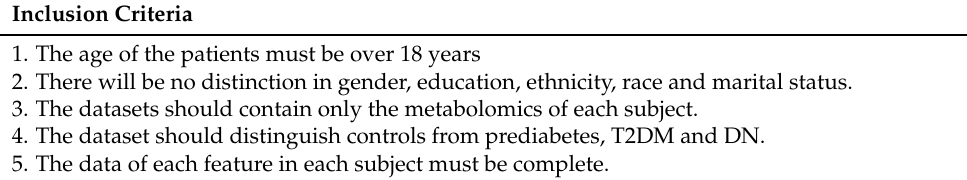
Figure 1. Flowchart of the proposed methodology. The blue squares refer to the data analysis methodology, while the white squares detail the task involved in each step. ( A ) The metabolomics dataset is obtained from the Unidad de Investigación Médica Biomedica. ( B ) The dataset is analyzed and new datasets are created by selecting subjects according to the criteria described in Table 1. ( C ) The data are normalized by probabilistic quotient normalization (PQN) and the dataset’s observations are analyzed and separated in three groups: Control-Prediabetes, Control-Diabetes and Control-DN. ( D ) The use of genetic algorithms is implemented to extract the main data features. ( E ) Using the main features for prediabetes, diabetes and diabetic nephropathy detection in patients, several models are generated using support vector machines, k-nearest neighbor and nearest centroid. ( F ) The validation of our results is carried out using different metrics (cross-validation by GALGO and average accuracy) to determine which of the models has the best performance. Table 1. Inclusion